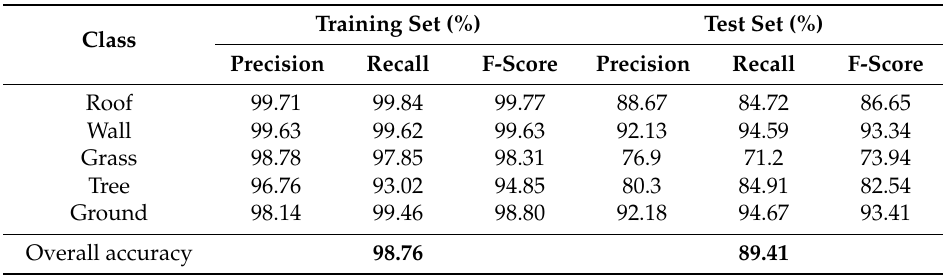
Table 5. Quantitative evaluation of point-based classification of Dataset1. Training Set (%) Test Set (%) Class Recall